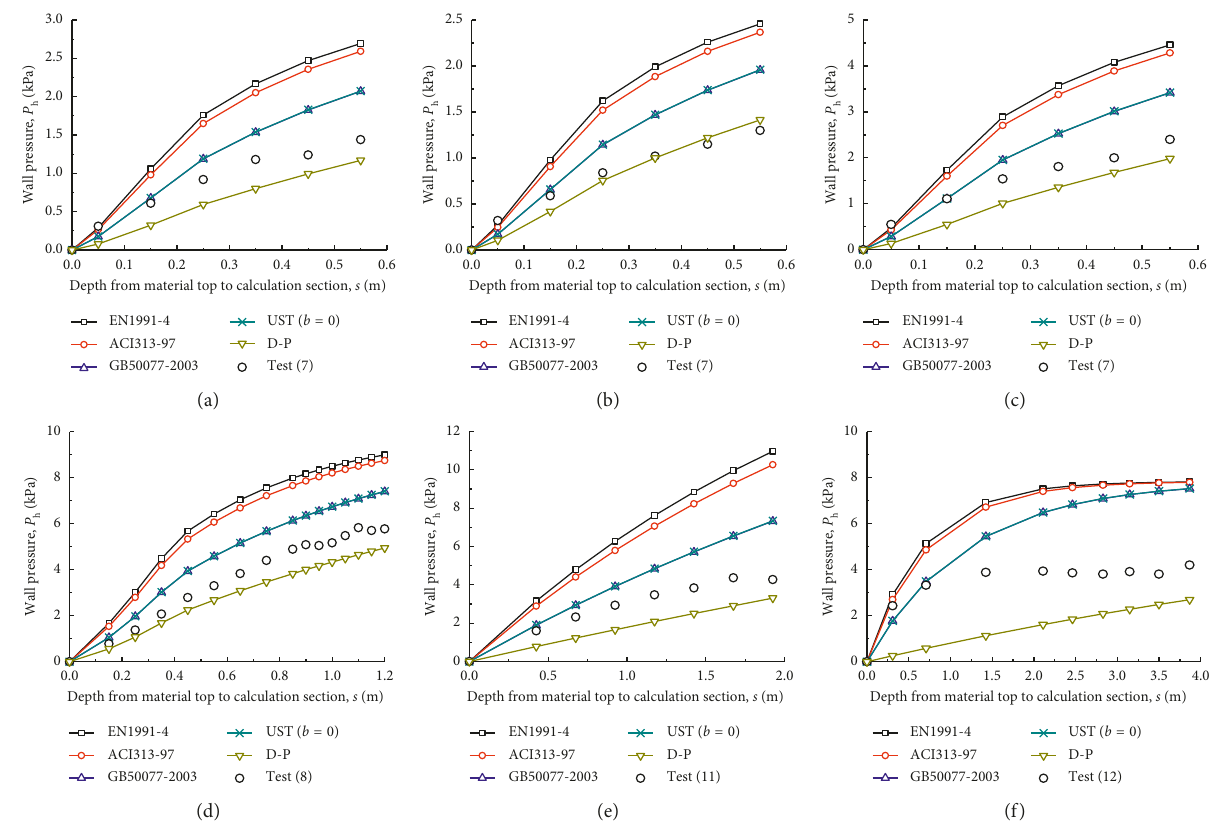
Figure 4: Comparisons of the results from three standards and two strength criteria with experimental data for deep silos. (a) Experimental data with coal from Liu and Hao [7]. (b) Experimental data with wheat from Liu and Hao [7]. (c) Experimental data with dry sand from Liu and Hao [7]. (d) Experimental data with standard sand from Zhang et al. [8]. (e) Experimental data with wheat from Ruiz et al. [11]. (f) Experimental data with dry sand from Munch-Andersen et al.